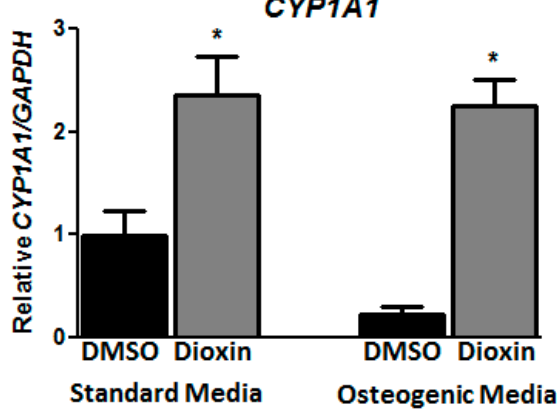
Figure 1. Dioxin induces CYP1A1 under both standard and osteogenic conditions. Expression of CYP1A1 mRNA after treatment with 100 nM dioxin or dimethyl sulfoxide (DMSO) vehicle control in cells grown under standard growth medium or osteogenic induction medium confirms that the AhR pathway is intact and functional in MG-63 cells. mRNA expression levels were normalized to DMSO vehicle control-treated cells grown in standard media. * p < 0.05 relative to 0 nM dioxin under standard or osteogenic conditions. Error bar means ± SEM.